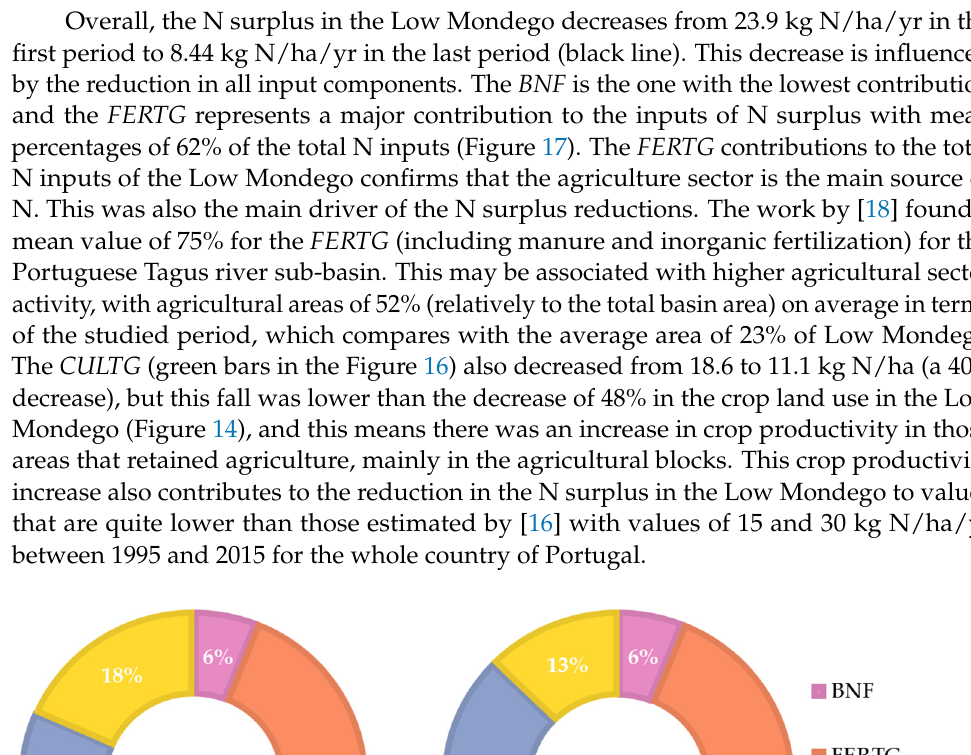
Figure 16. Nitrogen surplus in Low Mondego and the contribution of the different terms.